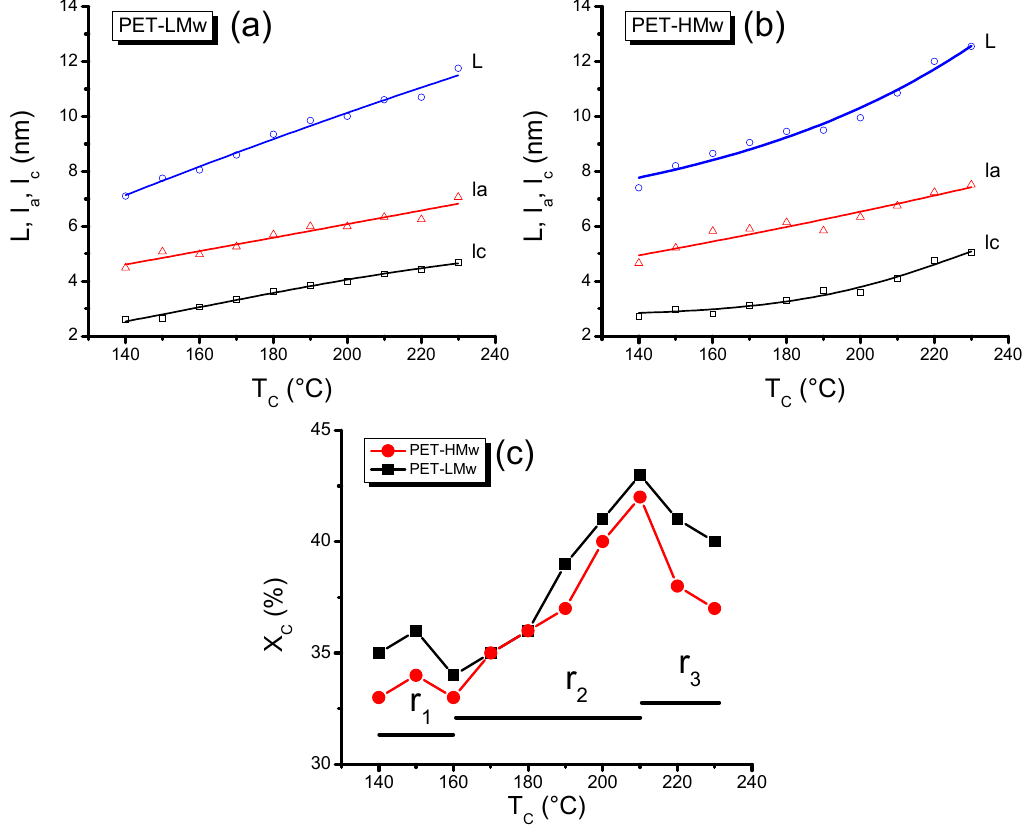
Figure 10. Morphological parameters ( L , l a and l c) of isothermally crystallized PET at different temperatures: ( a ) PET-LMw; ( b ) PET-HMw; and ( c ) Crystalline degree of isothermally crystallized PET. Data were obtained from SAXS